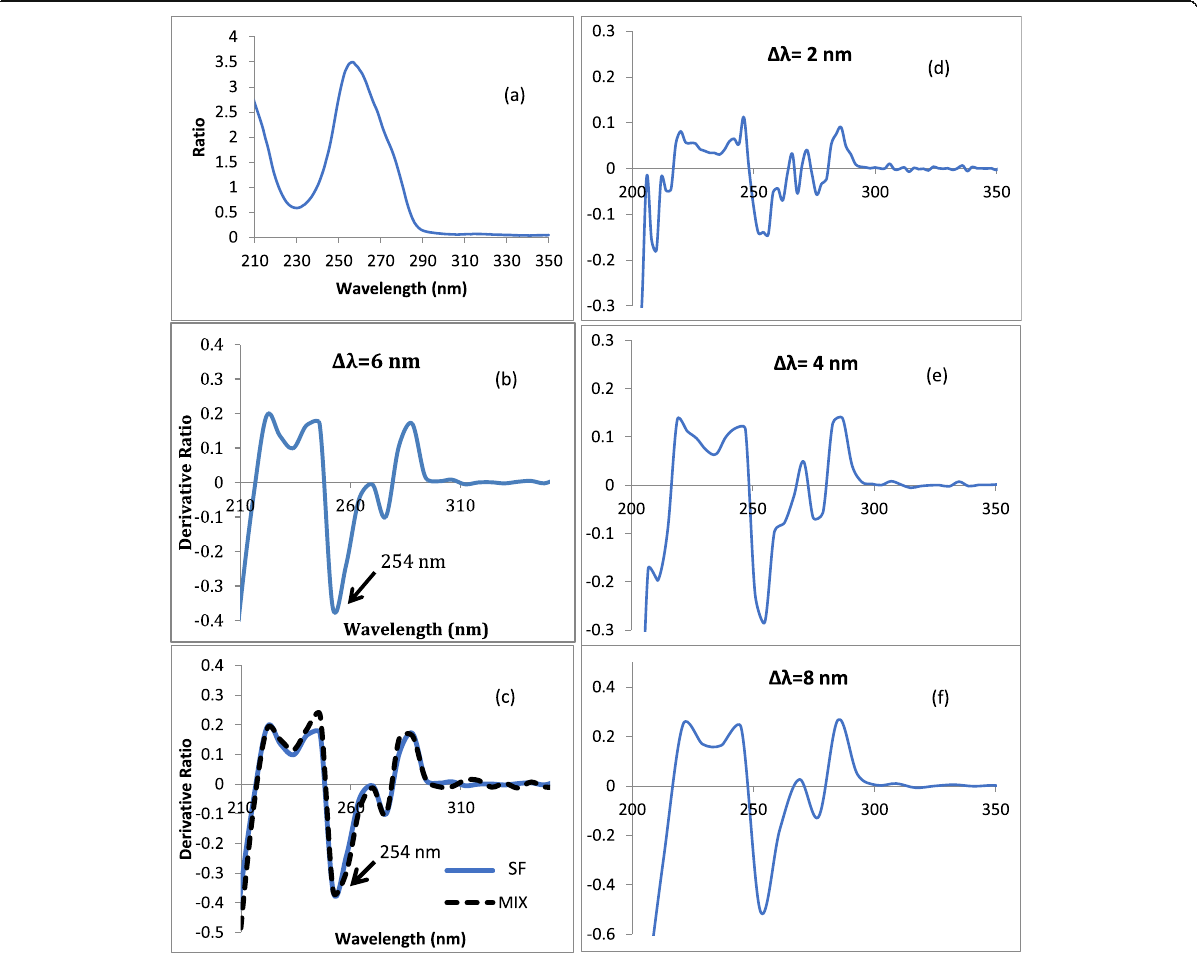
Fig. 2 a Ratio spectrum of 40 μ g/mL SF using a devisor of 10 μ g/mL VP, b second derivative ratio spectrum of 40 μ g/mL SF using 10 μ g/mL VP divisor at Δ λ = 6 nm, c second derivative spectrum of ratio spectra of 40 μ g/mL SF using 10 μ g/mL VP divisor superimposed with the synthetic mixture of 40 μ g/mL SF and 10 μ g/mL VP using 10 μ g/mL VP divisor, d second derivative spectrum of ratio spectrum of 40 μ g/mL SF